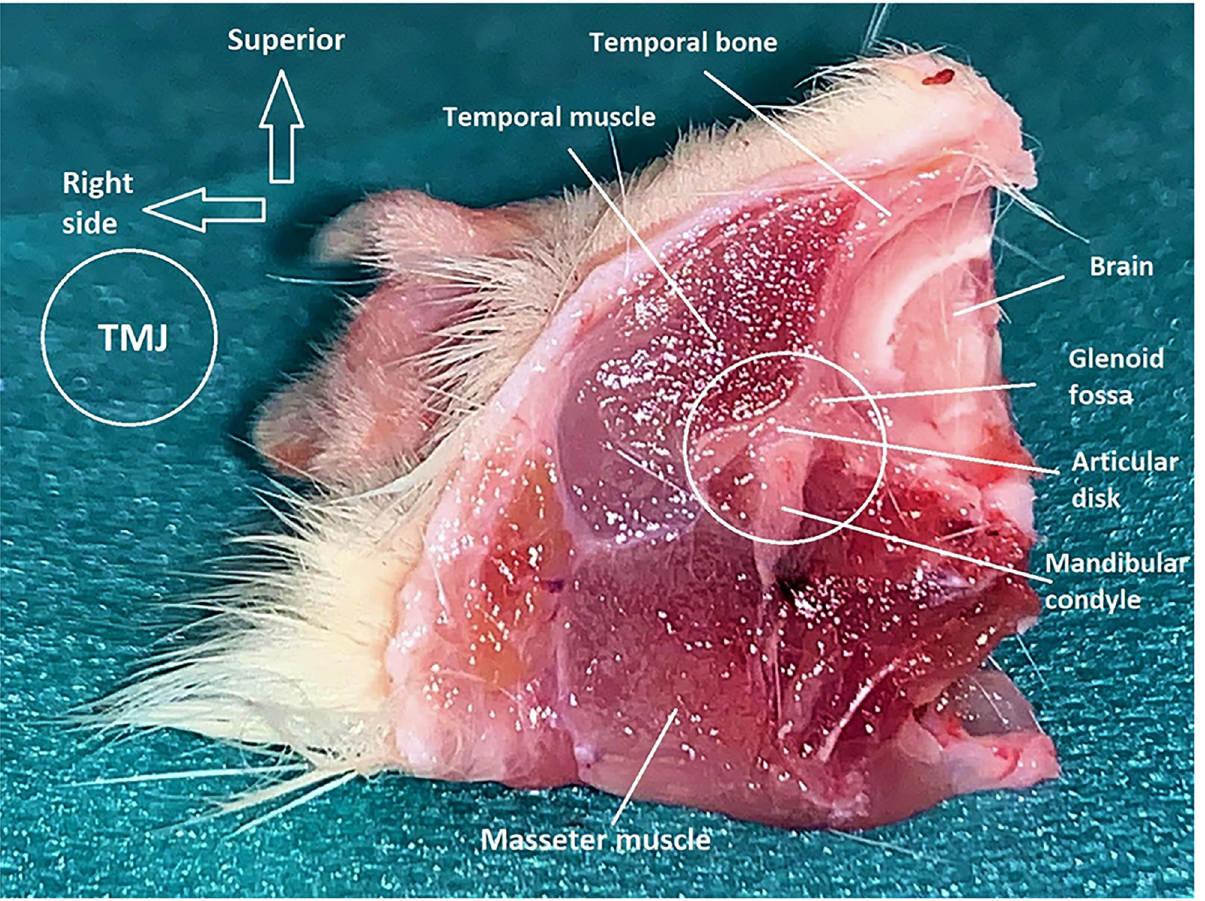
Fig 2. Entire TMJ sample with description.